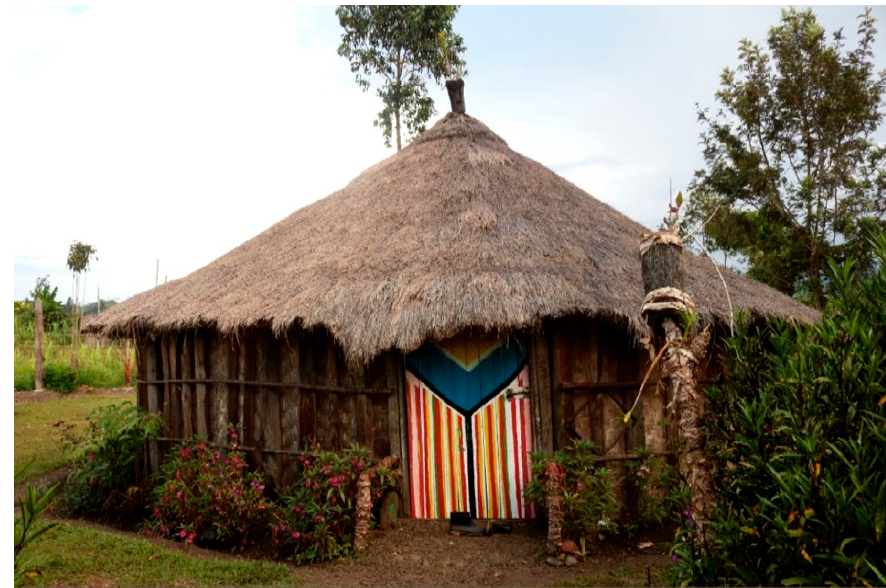
Figure 17. The round house in Wahgi Valley, Jiwaka Province, Papua New Guinea, built by Eric Bridgeman’s extended Yuri family. Members of the art collective Haus Yuriyal meet to paint and bilas (to beautify) their community. Photograph by Eric Bridgeman.